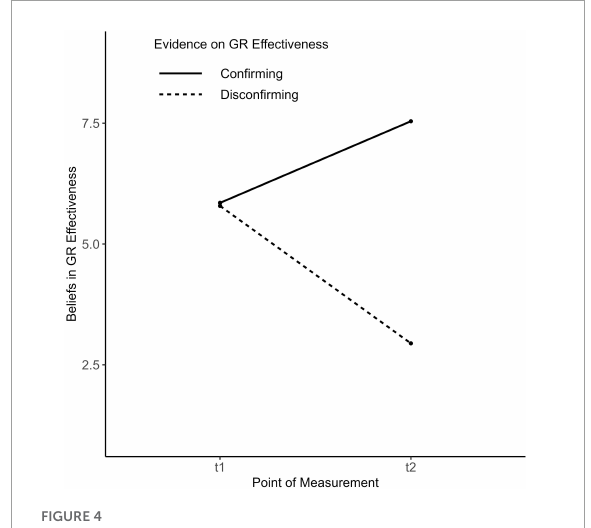
FIGURE4 Belief change regarding the effectiveness of grade retention (Study